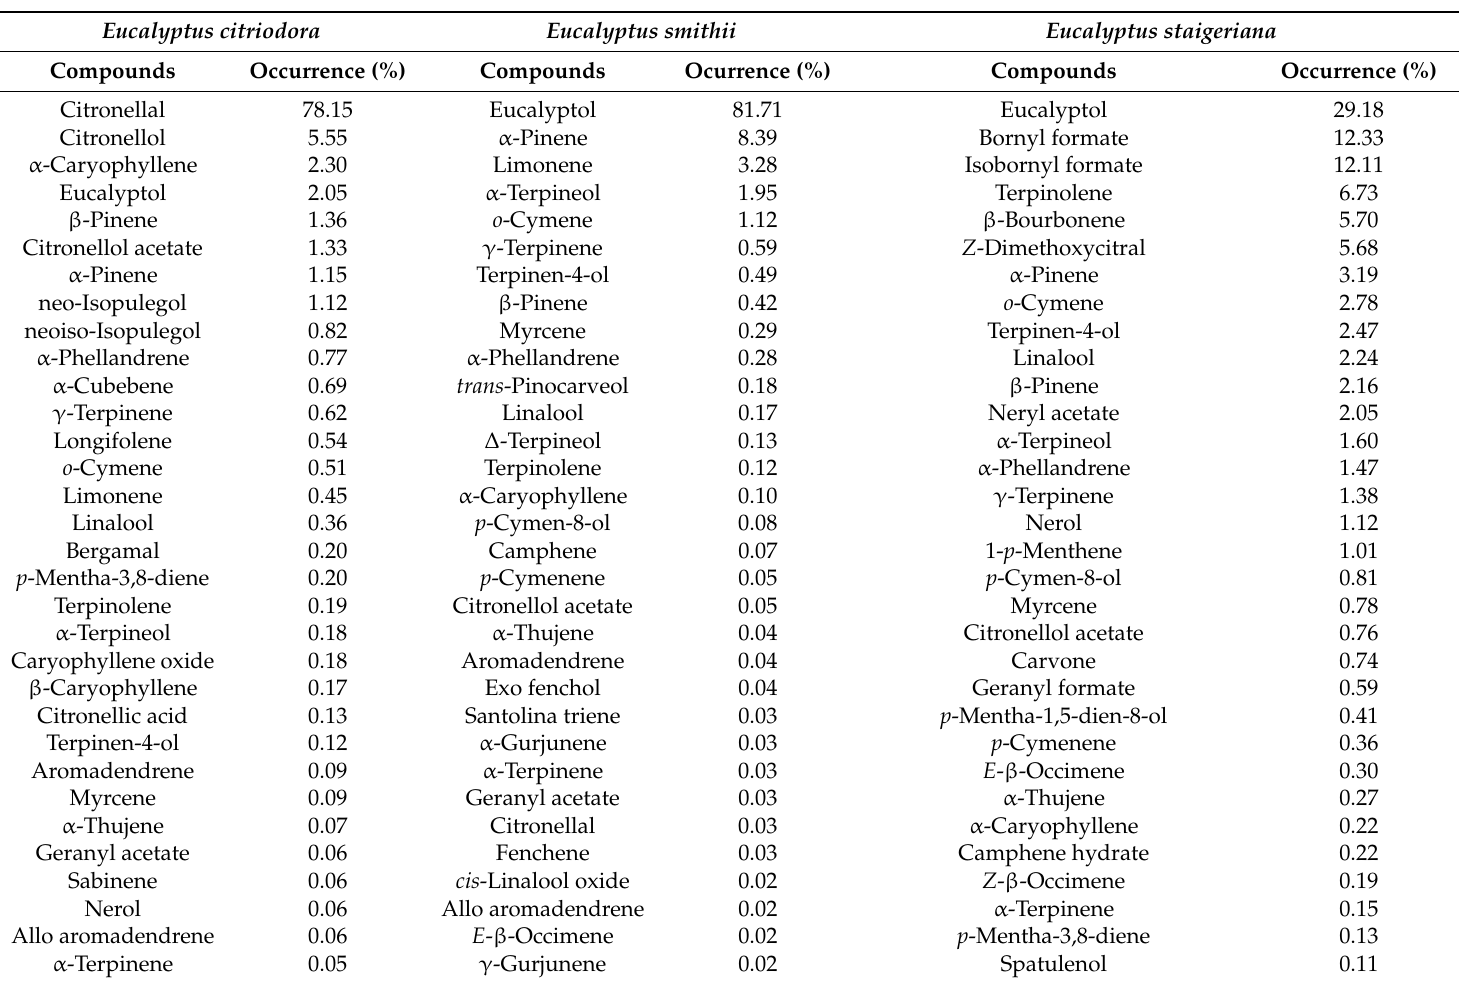
Table 2. Chemical composition (% of compound) of the Eucalyptus species